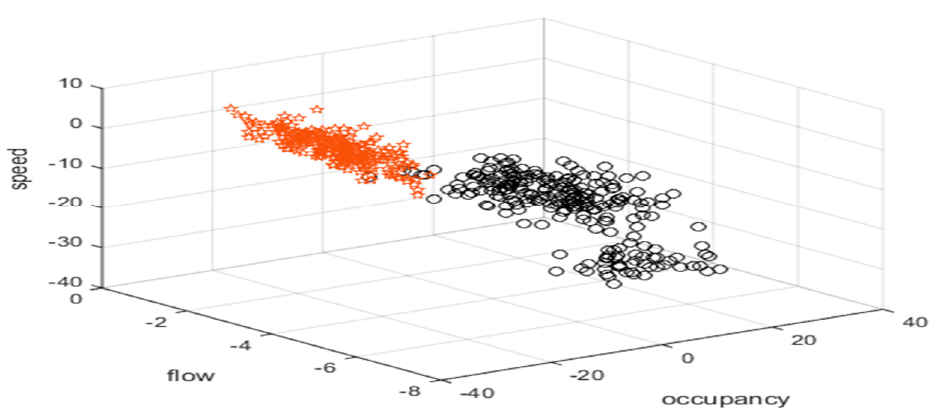
Figure 7. Distribution of traffic flow data at 5 s interval with and without sudden fire disasters.